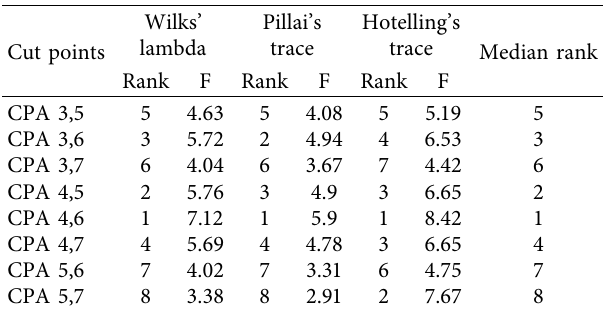
Table 4: Depressive disorders.